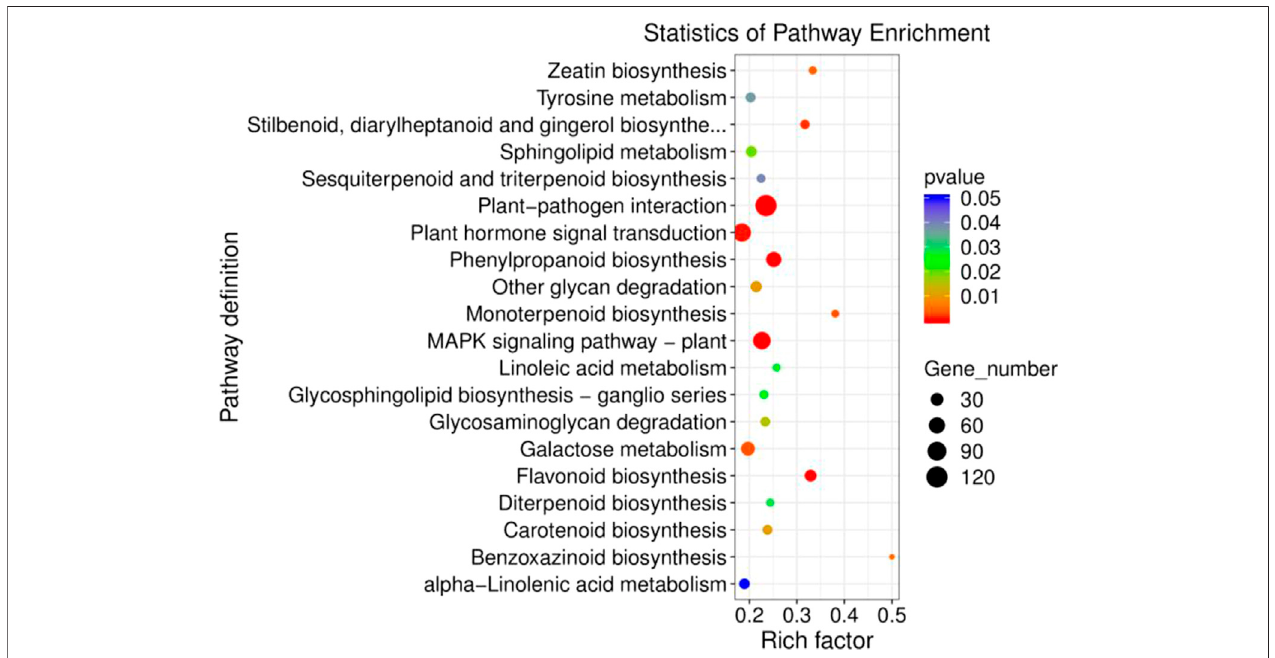
FIGURE 7 | Analysis of D_R vs S_R differentially expressed gene KEGG